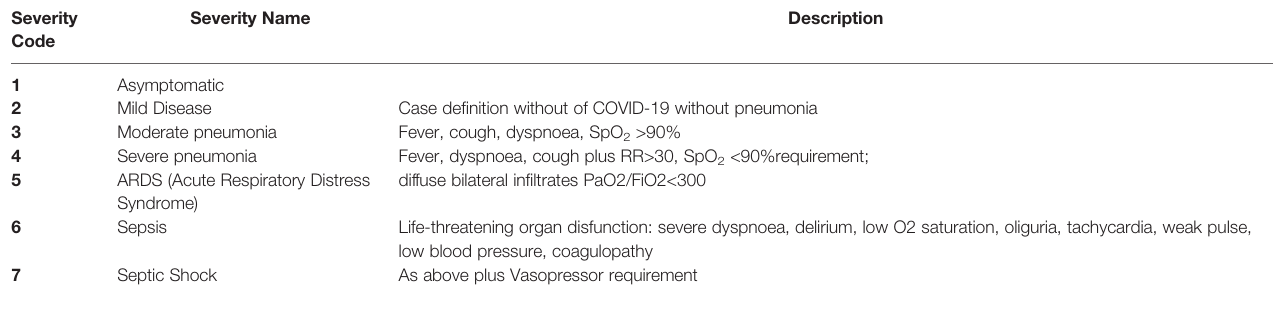
TABLE 1A | Severity score classi fi